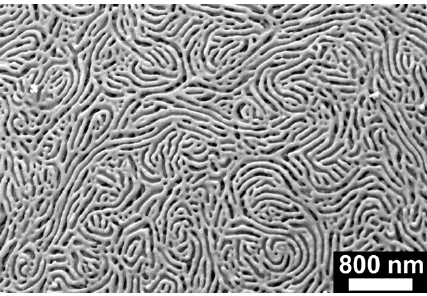
Figure 3. Representative scanning electron microscopy image of the surface of NMMA-12.5.